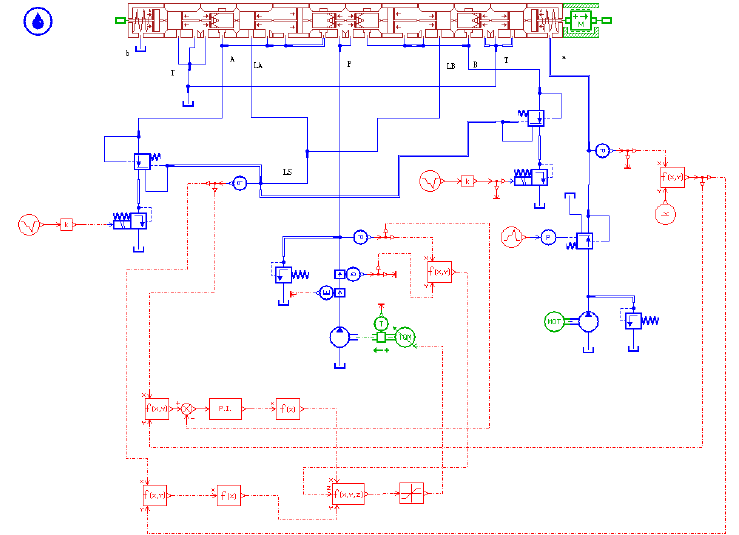
Figure 8. AMESim simulation model of constant power control.